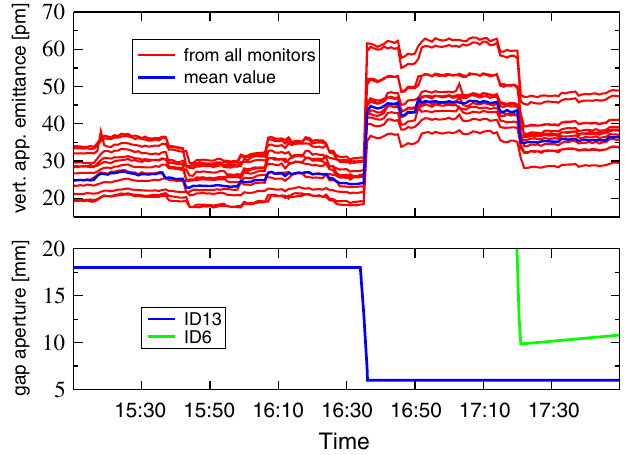
FIG. 5. Record low vertical apparent emittances E along the ESRF storage ring on July 22, 2010 at ID gaps open. The horizontal dashed line denotes the mean values between the ten (out of 11) available x-ray monitors. The D09 and D25 were taken out of the average, see main text.